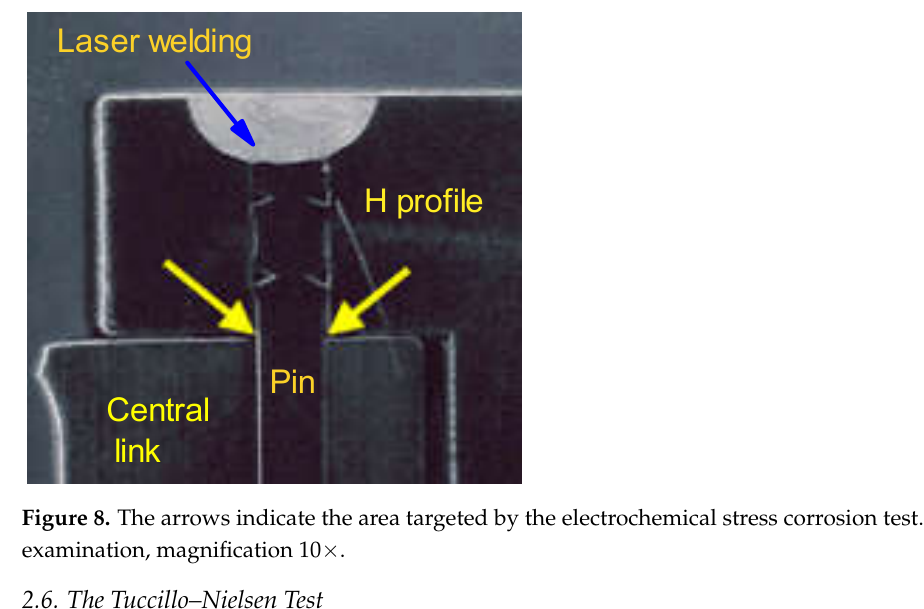
Figure 8. The arrows indicate the area targeted by the electrochemical stress corrosion test. Optical examination, magnification 10×.